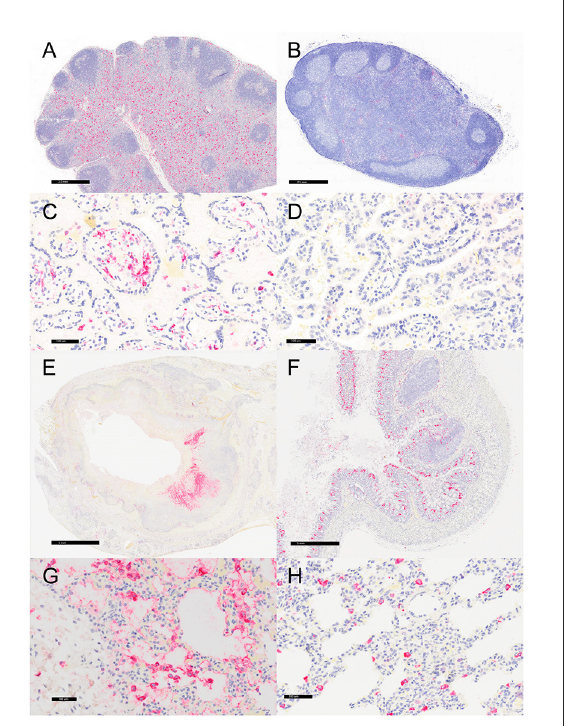
FIGURE4 Immunohistochemistry for HAM56, vervets, multiple organs. (A) Y. enterocolitica- positive vervet, mesenteric lymph node, case 6. About 40% of the cells within the medullary sinus are HAM56-positive macrophages. This lymph node was adjacent to a colonic lesion. (B) Control vervet, mesenteric lymph node. A control lymph node contains few HAM56-positive macrophages ( < 10%). (C) Y. enterocolitica- positive vervet, placenta, case 20. Abundant HAM56-positive macrophages are present in fetal villi and also within maternal blood. (D) Control vervet, placenta. HAM56-positive macrophages are absent in the control placenta. (E) Y. enterocolitica- positive vervet, colon, case 3. HAM56-positive macrophages are present adjacent to necrosis. (F) Control vervet, colon. Macrophages are distributed throughout the colonic mucosa. (G) Y. enterocolitica- positive vervet, lung, case 1. Macrophages are prominent in alveoli at the periphery of necrotic lesions. (H) Control vervet,